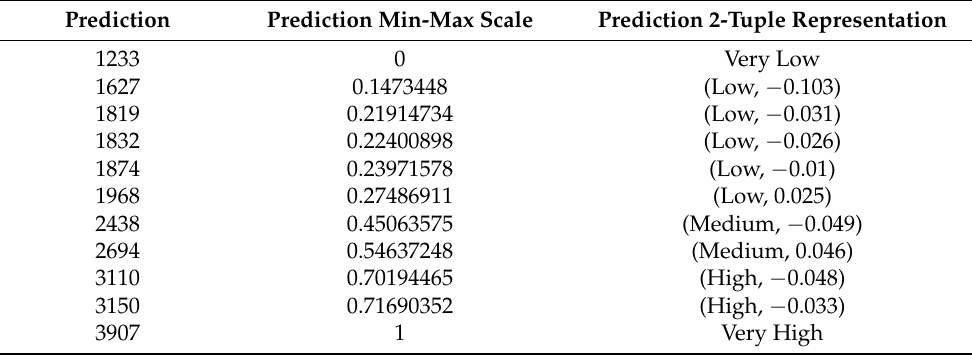
Table 5. 2-tuple representation of the predicted target variable.